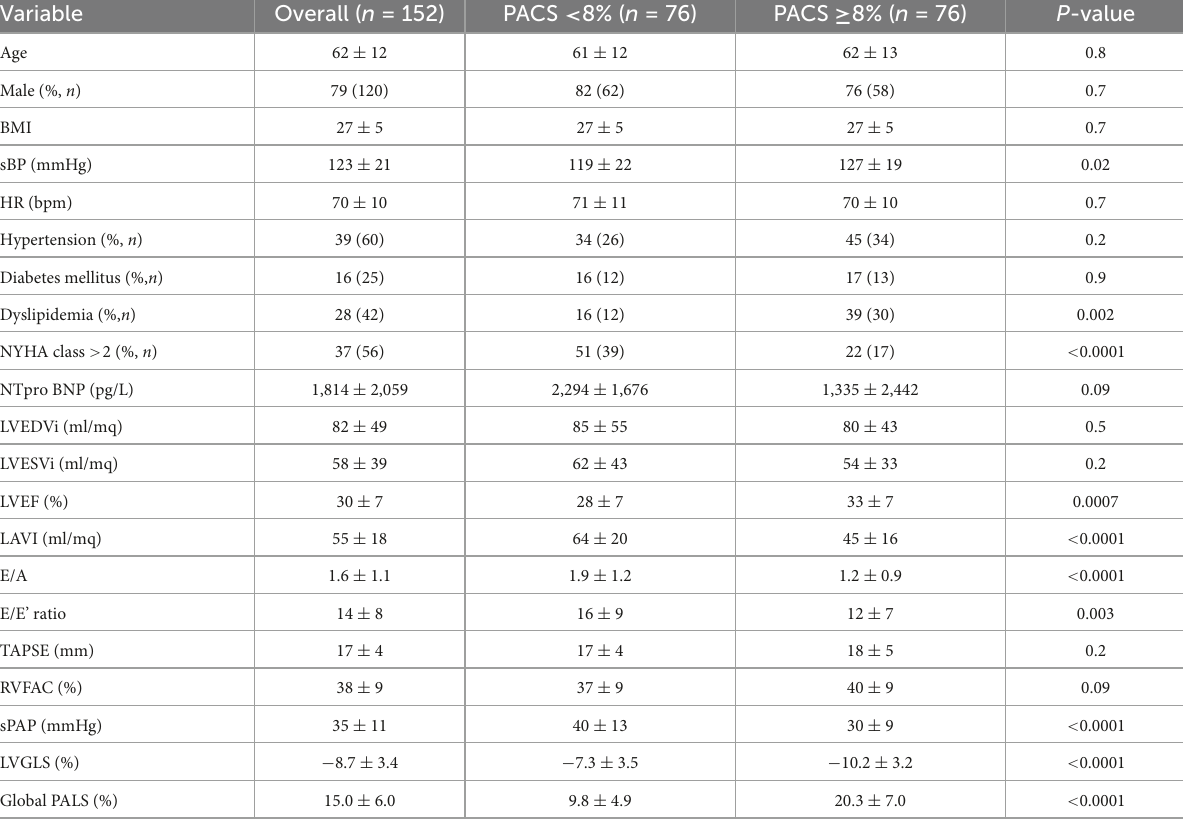
TABLE 1 Clinical and echocardiographic characteristics of heart failure with reduced ejection fraction (HFrEF) patients according to PACS values.